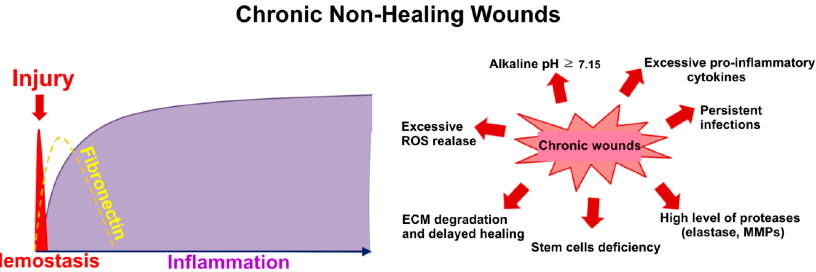
Figure 2. Main features of chronic wounds (ECM: extracellular matrix, MMPs: matrix metalloproteinases, ROS: reactive oxygen species).